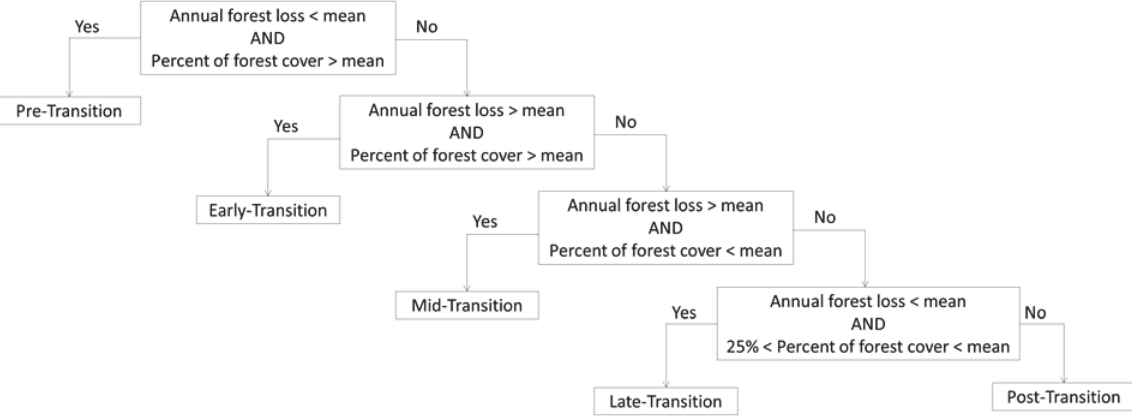
Figure 1 Decision tree of forest trajectories analysis